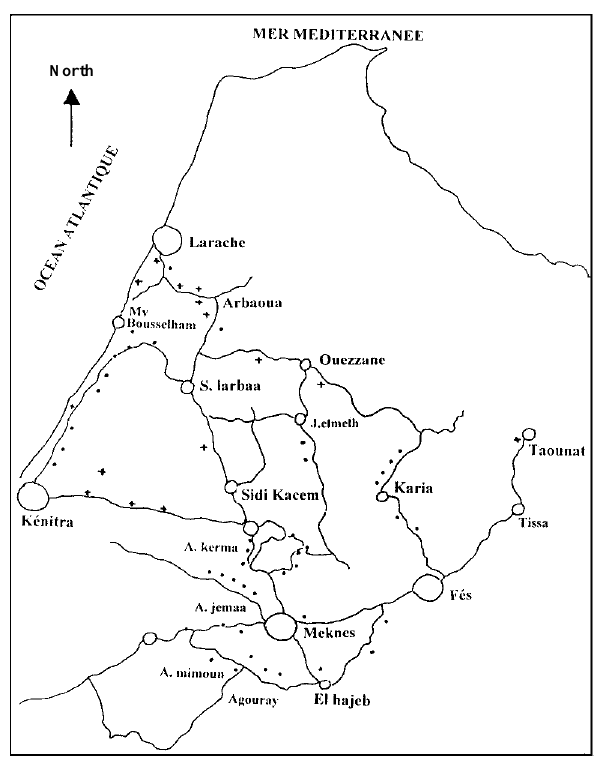
Fig. 4. Map of Morocco (north, centre) showing main sunflower production areas and mildew incidence in the crop years 1996 and 1997 (scale : 1cm =